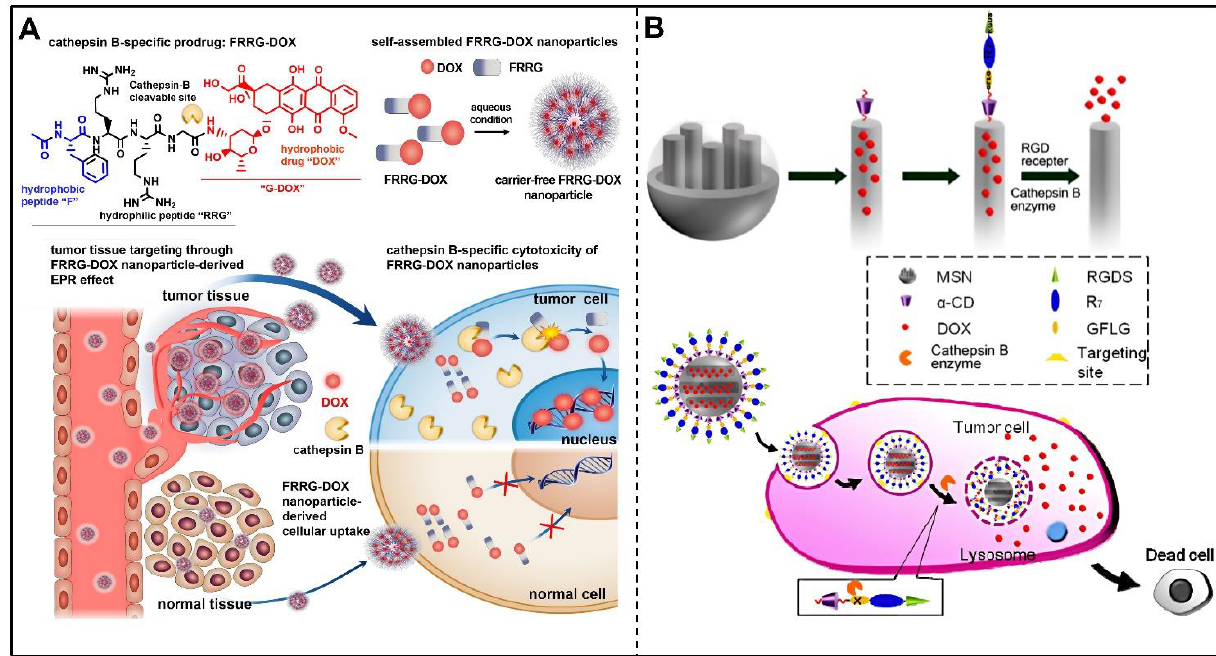
Figure 5. Design and responsive mechanism of Cat-B-triggered srNPs. ( A ) Schematic representation of construct of FRRG-DOX nanoparticles and its tumor-targeting cytotoxicity due to the Cat-B-specific enzyme. Reproduced with permission [108]. Copyright 2019, Elsevier. ( B ) Cat-B-induced procedure and targeting intracellular application of the MSNs. Reproduced with permission [106]. Copyright 2015, American Chemical Society.